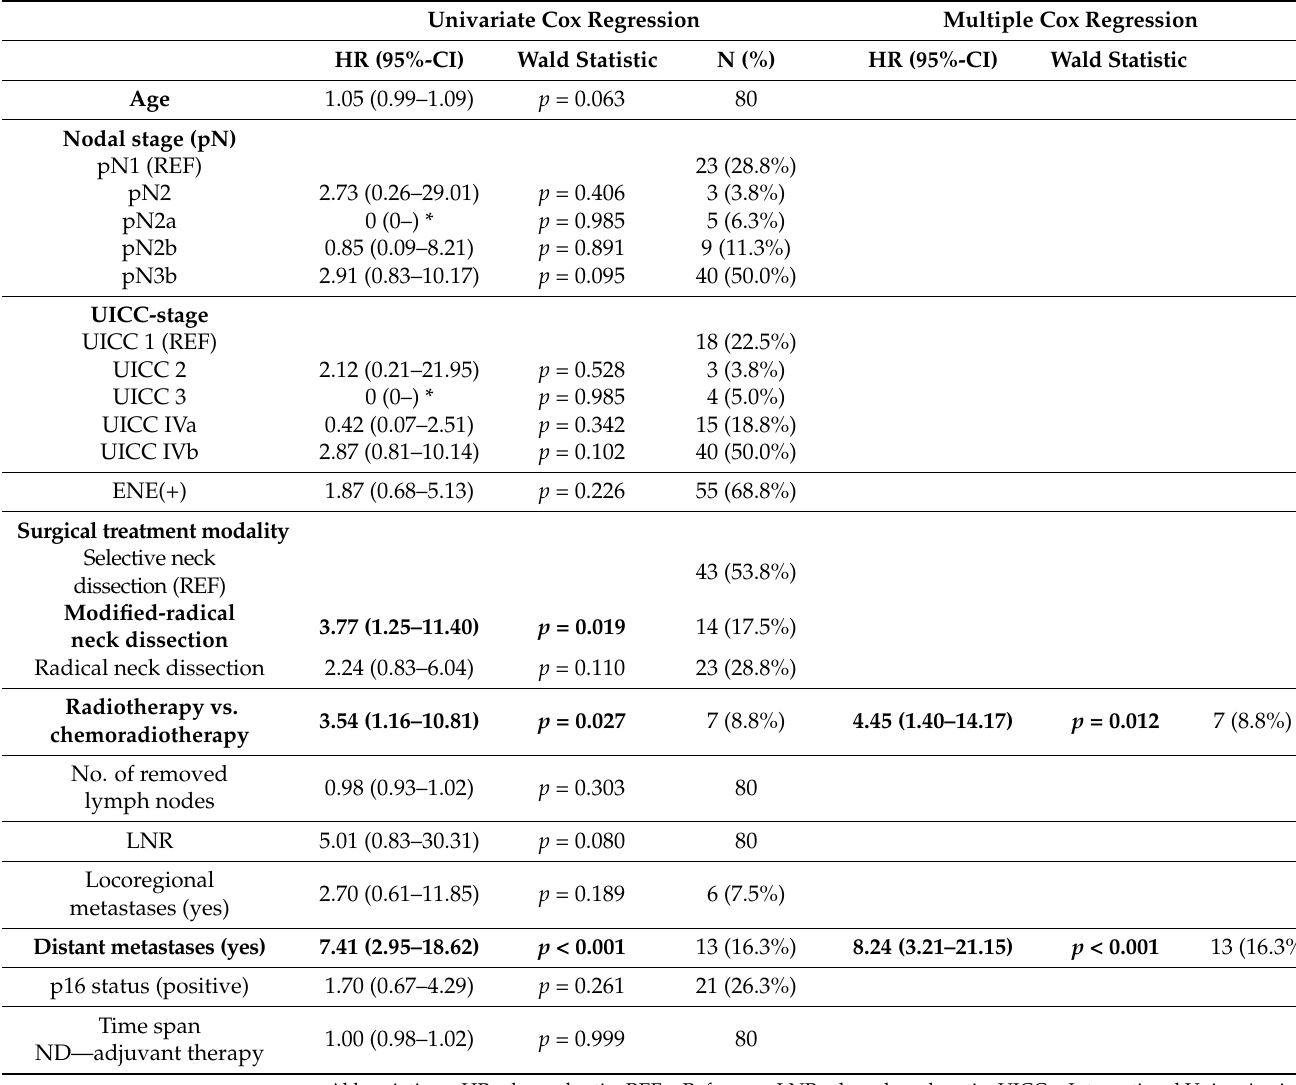
Table 4. Univariate and multiple Cox regression for OS. Univariate Cox Regression Multiple Cox